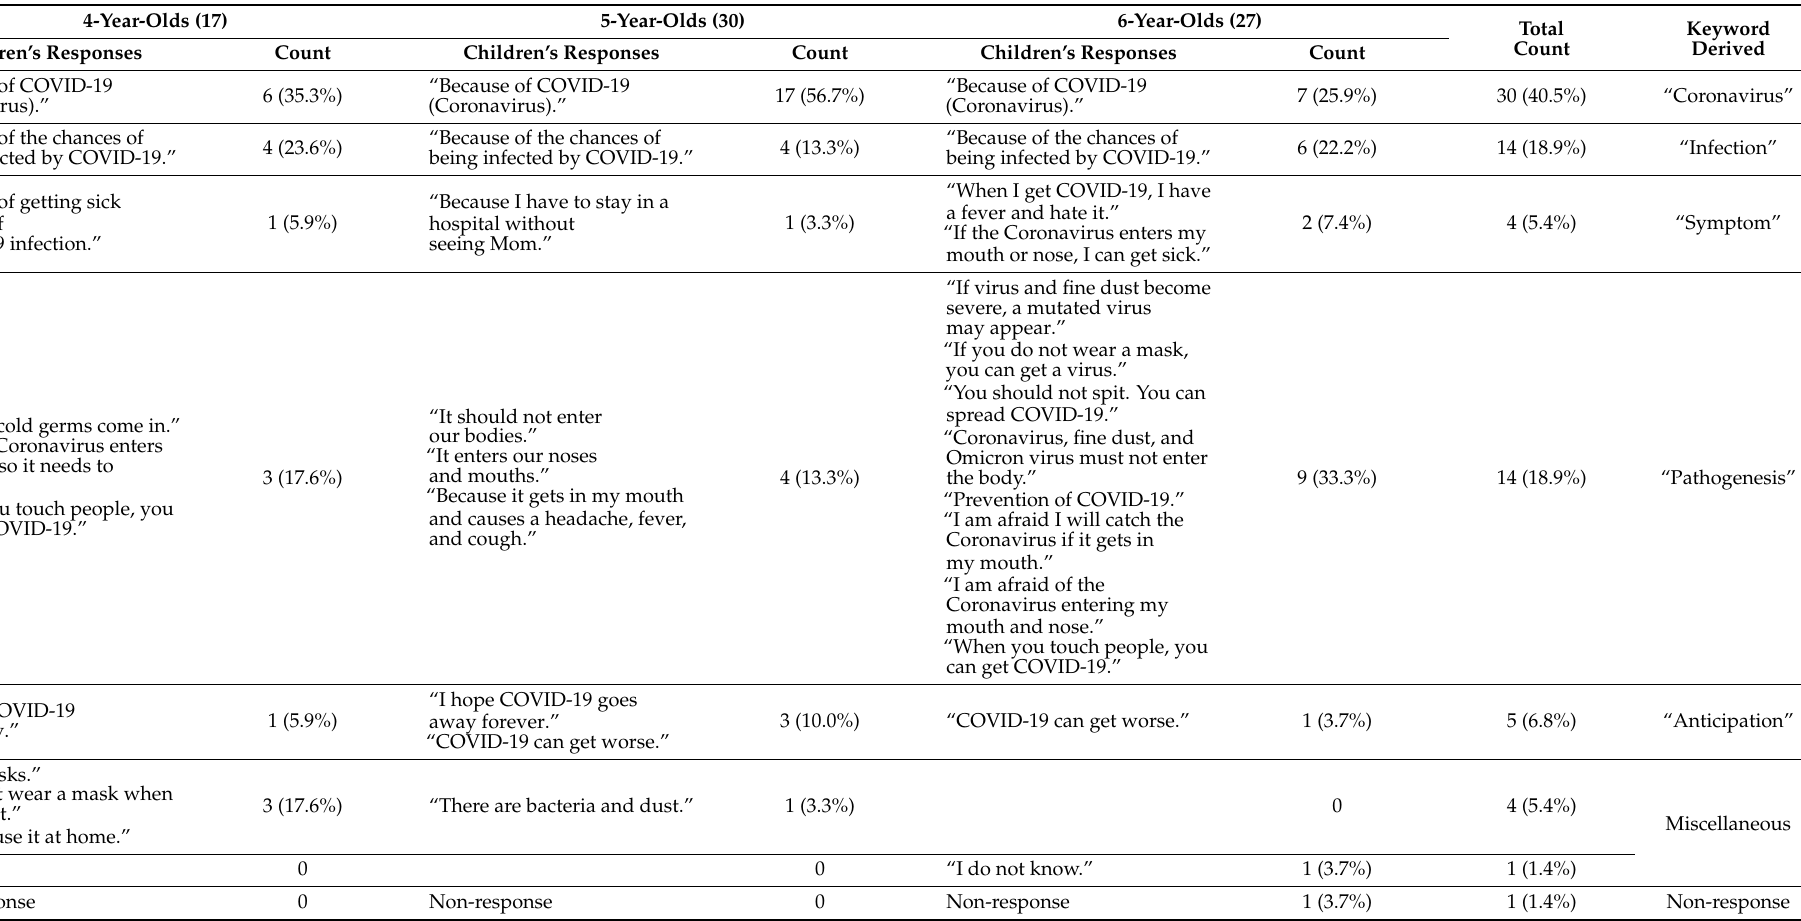
Table 5. Children’s responses to subjective question No. 1: Why do you wear a